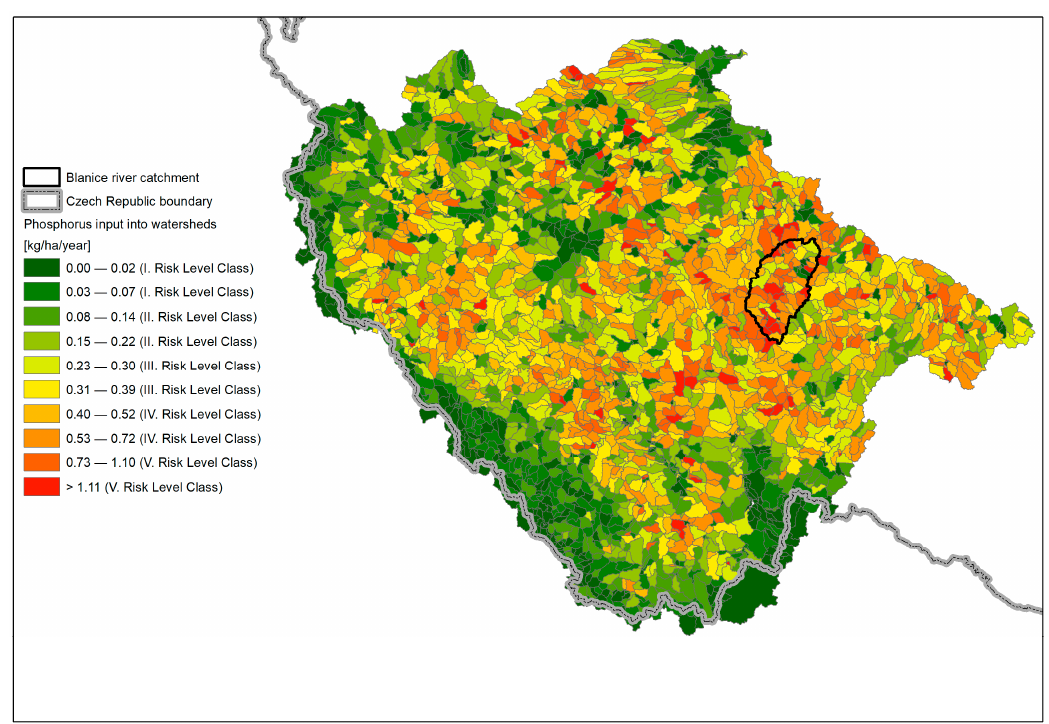
Figure 2. Sediment input into fourth-order catchments for the entire Vltava watershed area.